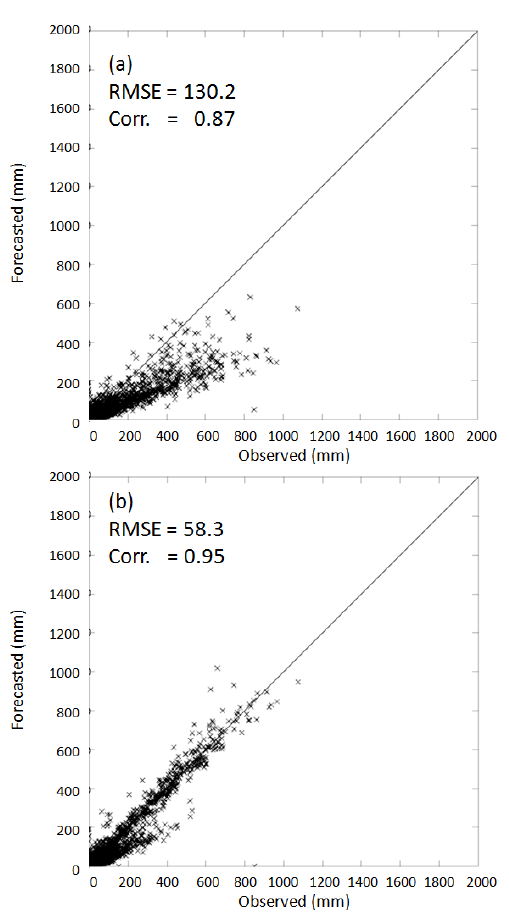
Fig 7. The forecasted (y axis) and observed (x axis) rainfall accumulations of the 2 Fig. 7. The forecasted (y-axis) and observed (x-axis) rainfall ac- dependent typhoons accompanied with northeastern monsoons (from 1989 to 2006) 3 cumulations of the dependent typhoons accompanied with north- for all rain gauge stations: (a) TRCM06; and (b) A-TRCM12. 4 eastern monsoons (from 1989 to 2006) for all rain gauge stations: (a) TRCM06; and (b) A-TRCM12.